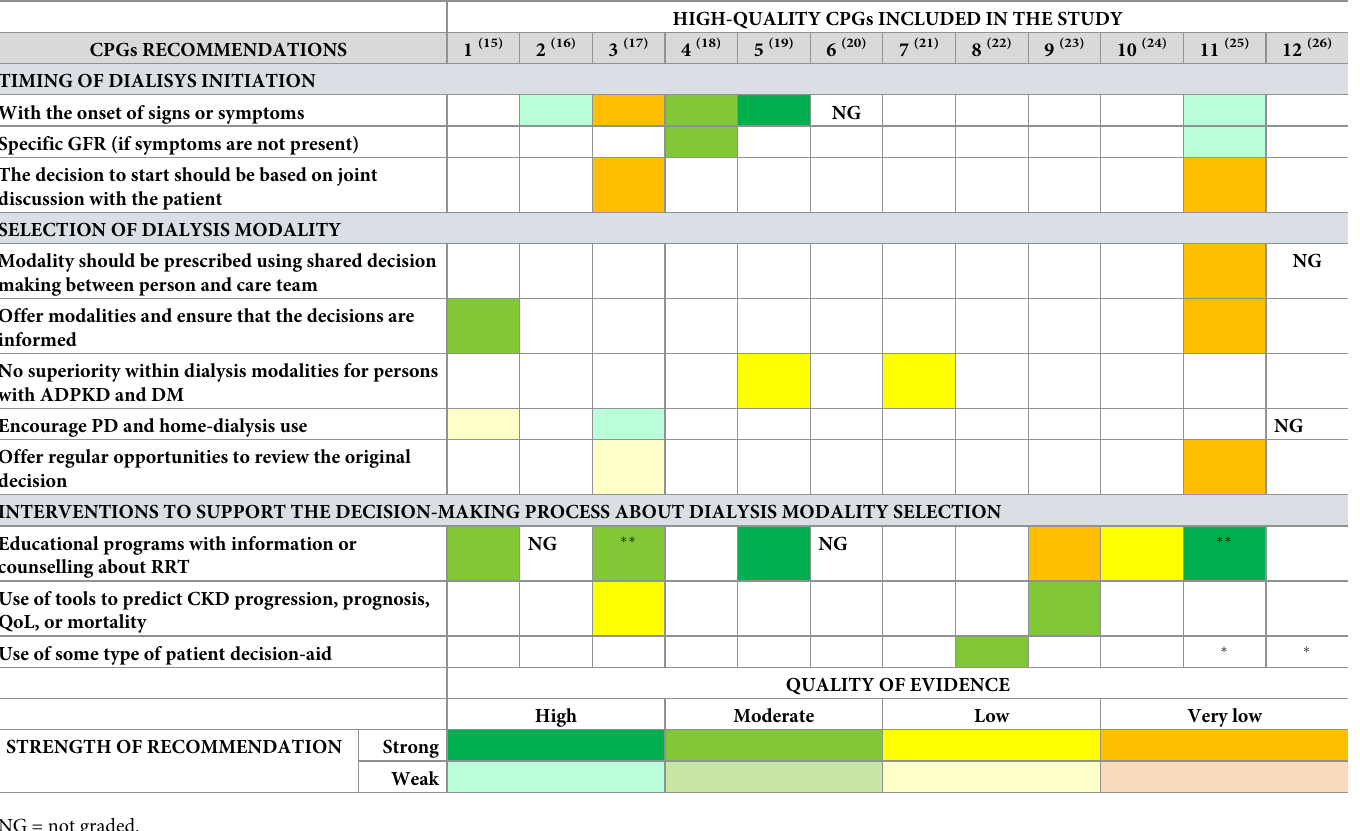
HIGH-QUALITY CPGs INCLUDED IN THE